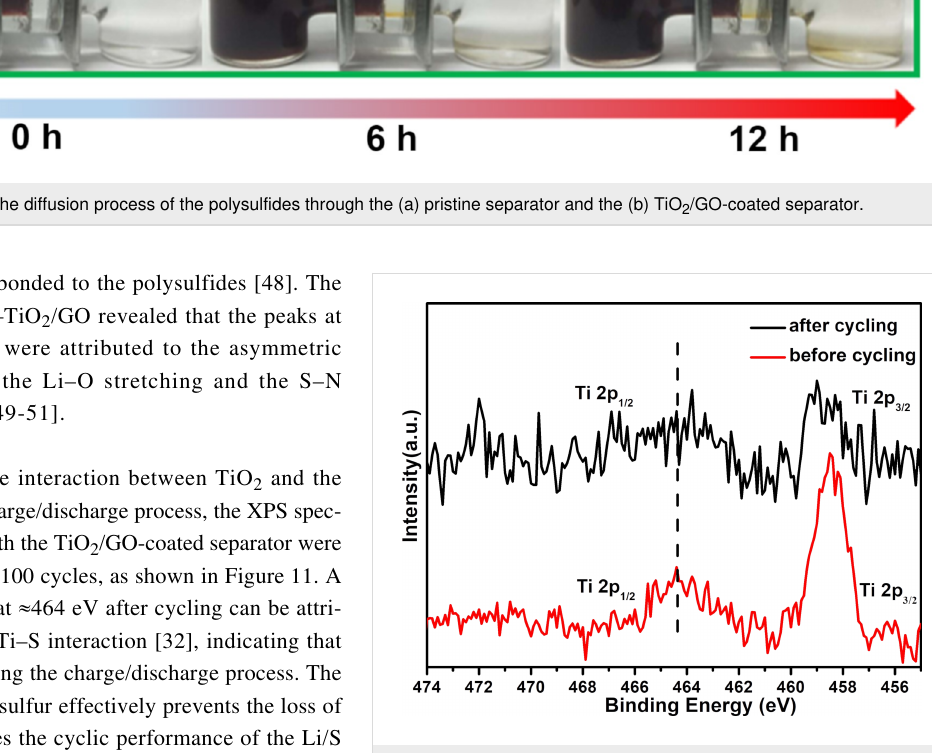
Figure 11: XPS spectra (Ti 2p) of the battery with a TiO 2 /GO-coated separator before and after charge/discharge